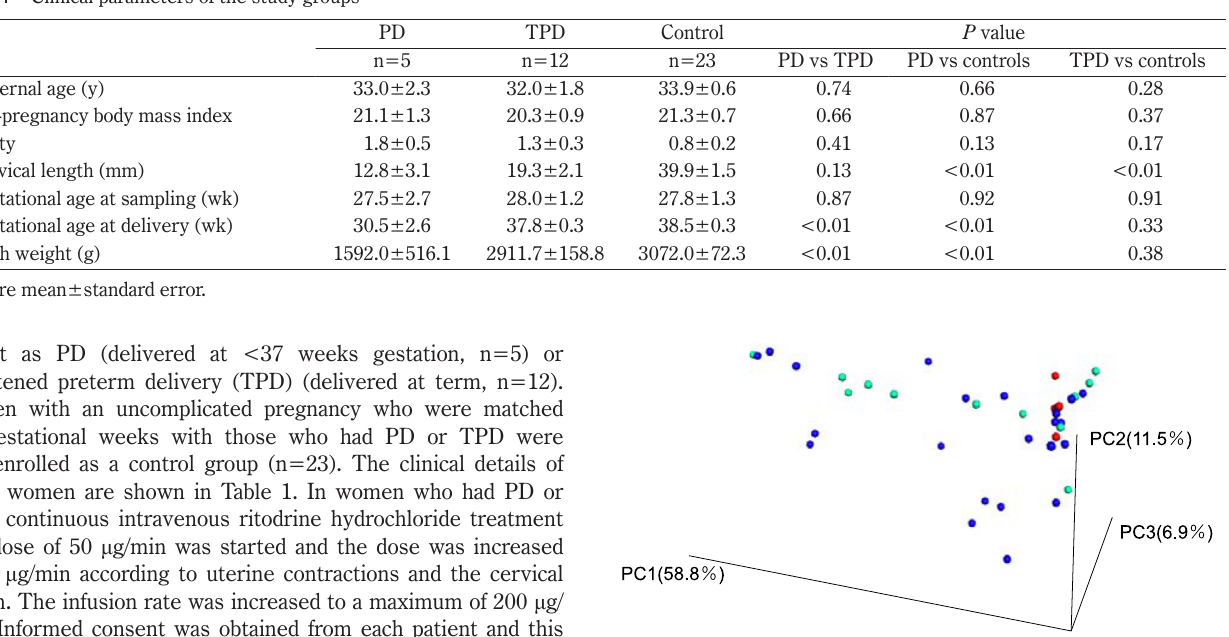
Table 1 Clinical parameters of the study